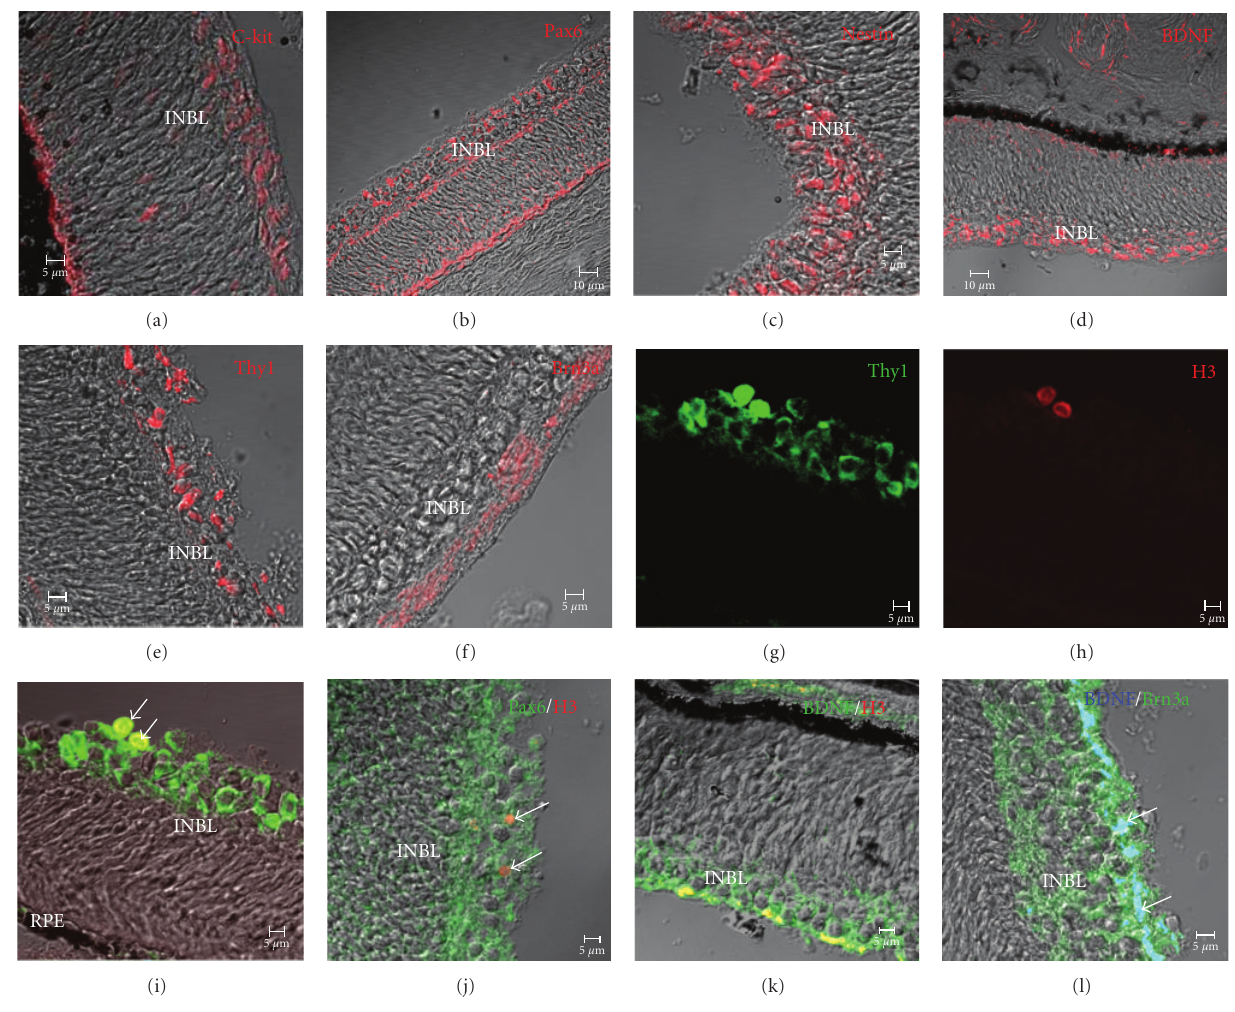
Figure 3: C-kit (a), Pax6 (b) and Nestin (c) expression in the retina from fetal stage. The expression pattern was evident in the INBL. At this stage the di ff erentiation of ganglion cells was evident as were the markers BDNF (d), Thy1 (e) and Brn3a (f). (g) Confocal image showing the Thy1 positive cells. (h) The same image was presented in (g) but made evident with H3. (i) Merged image, but the proliferation of Thy1 cells is evident, localized in INBL (arrows). (j) Merged image illustrates the colocalization of Pax6 positive cells with H3 positive cells (arrows). (k) Merged image illustrating proliferation of BDNF positive cells in the INBL made evident by H3 (yellow stained). (l) Colocalization of BDNF and Brn3a proteins distributed along the INBL